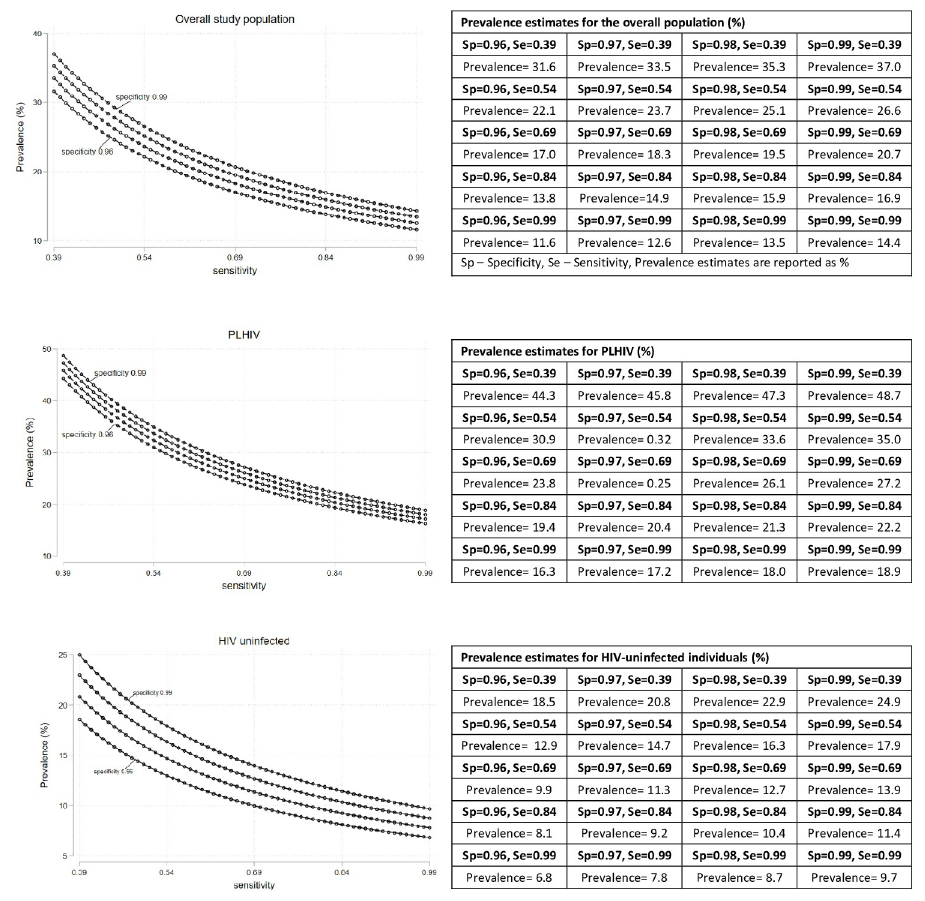
Fig 2. Corrected prevalence of OPMDs under different plausible sensitivity and specificity parameters assuming non-differential misclassification of suspected OPMDs (i.e., Sensitivity PLHIV = Sensitivity HIV uninfected ; Specificity PLHIV = Specificity HIV uninfected